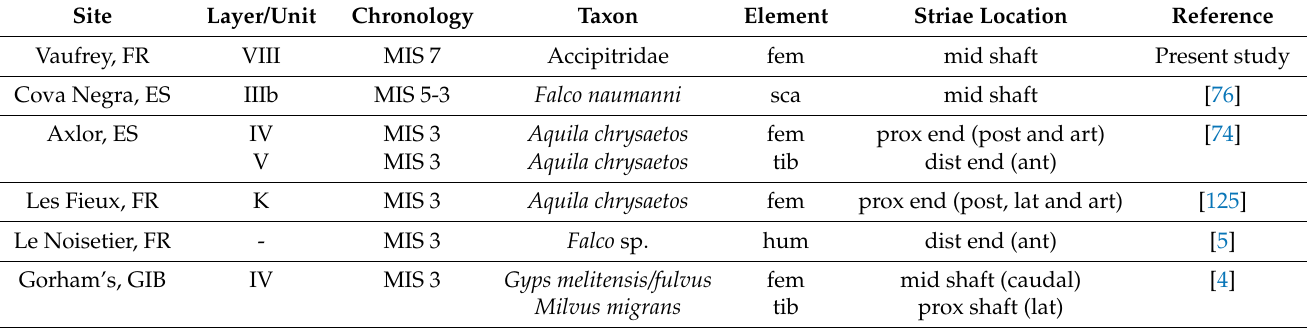
Table 4. Sites with evidence of possible raptor use for food. mid (middle), prox (proximal), dist (distal), ant (anterior), post (posterior), lat (lateral), art (articular). hum: humerus; sca: scapula; fem: femur; tib: tibiotarsus. FR: France; ES: Spain; GIB: Gibraltar (United